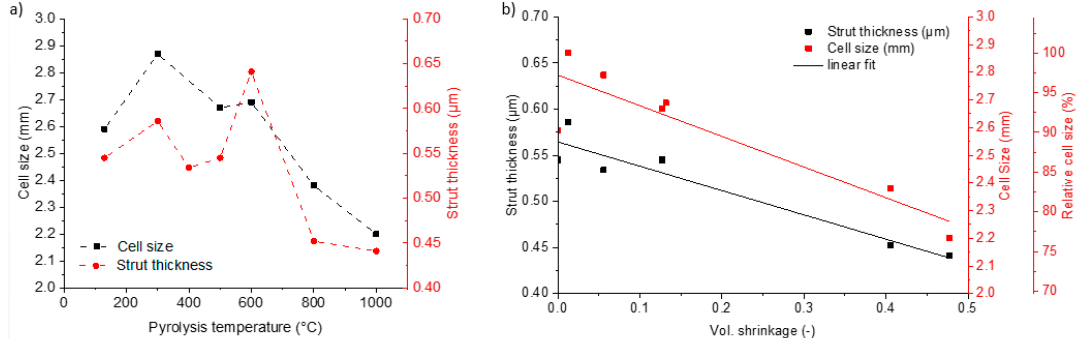
Figure 3. Dependence of the theoretical density of the strut material measured on crushed filler- loaded (Al 2 O 3 , SiC) and filler-free foams (oFS) and volumetric shrinkage of the temperature treated foams in dependence of the pyrolysis temperature.